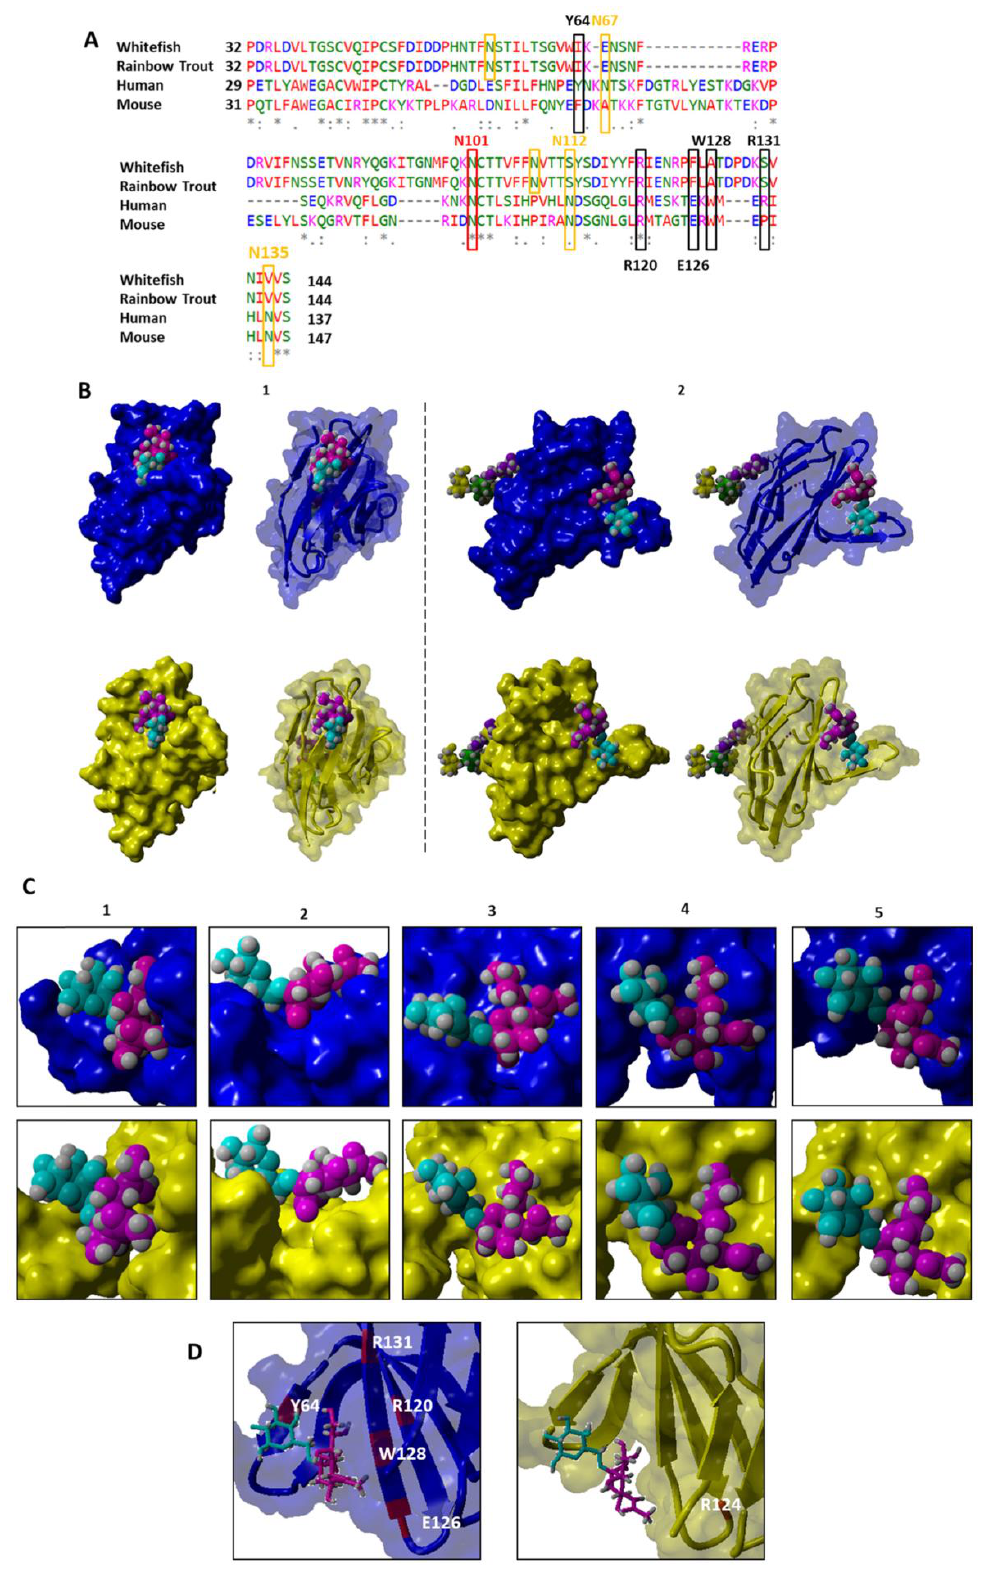
Figure 4. Sequence and structural comparison of CD22 from human and maraena whitefish. ( A ) The first Ig domain of maraena whitefish and rainbow trout was determined by aligning sequences. The different colors indicate the chemical properties of the amino acids as follows: red, small hydrophobic/aromatic amino acids; blue, acidic amino acids; magenta, basic amino acids; green, hydrophilic, polar, and small amino acids. Black boxes show the amino acids that are essential for